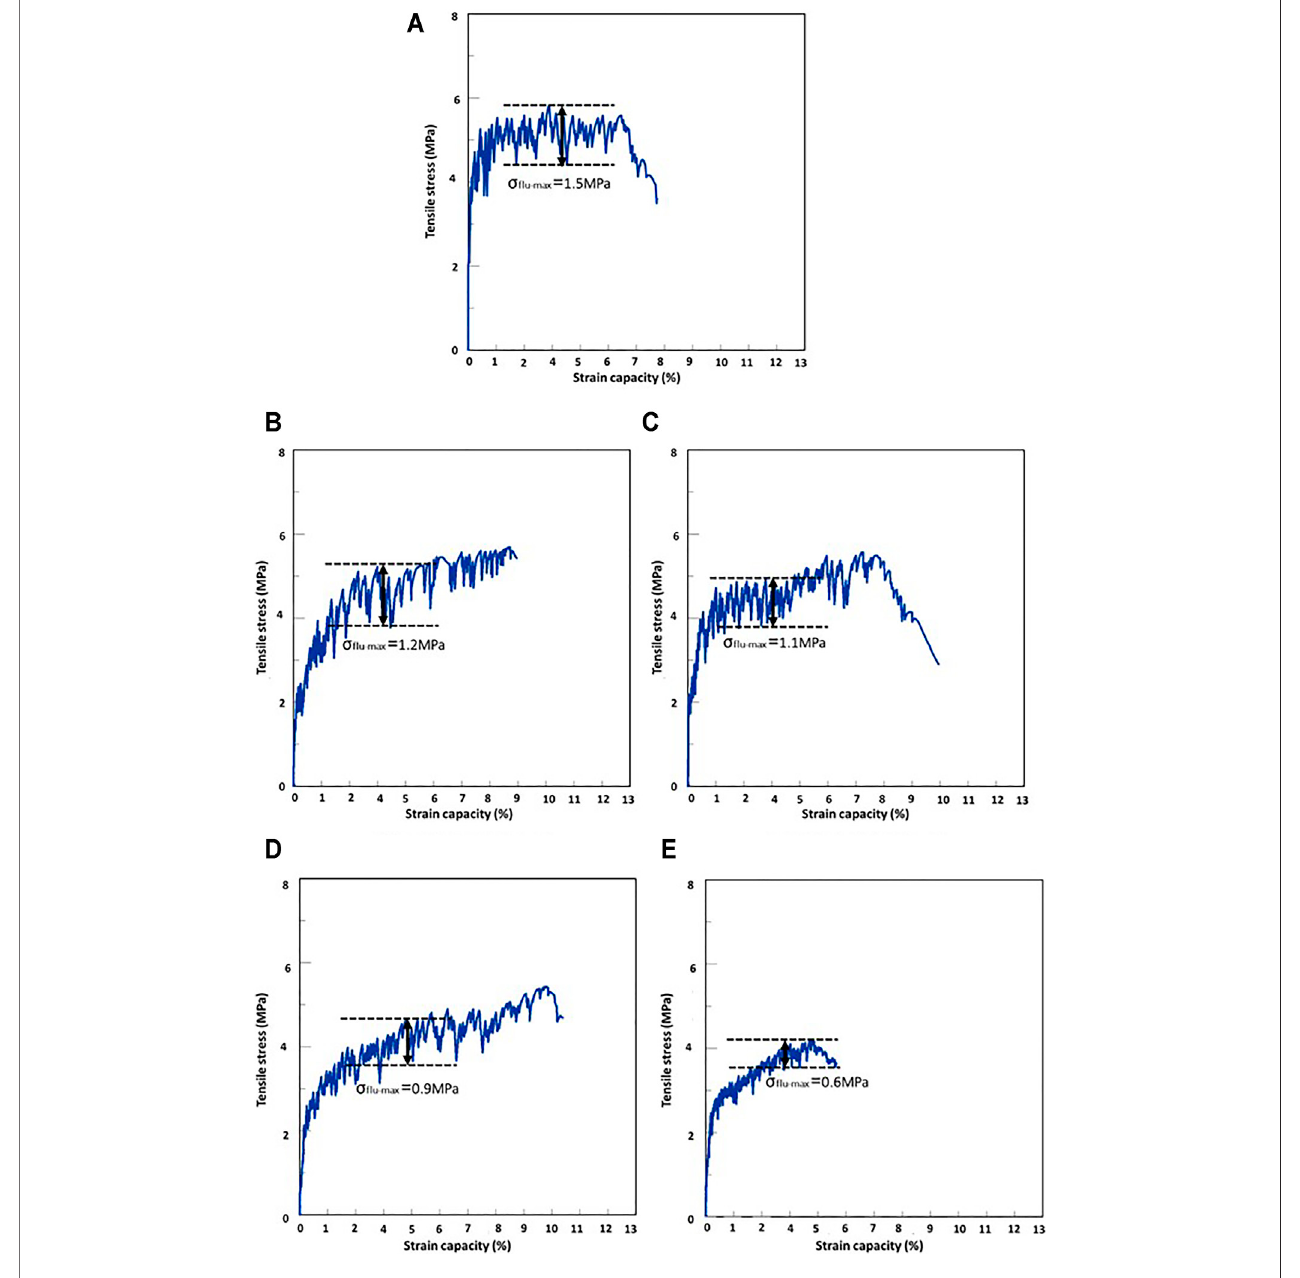
FIGURE 8 | (A) HGMLW-SHCC 0, (B) HGMLW-SHCC 25, (C) HGMLW-SHCC 50, (D) HGMLW-SHCC 75, (E) HGMLW-SHCC